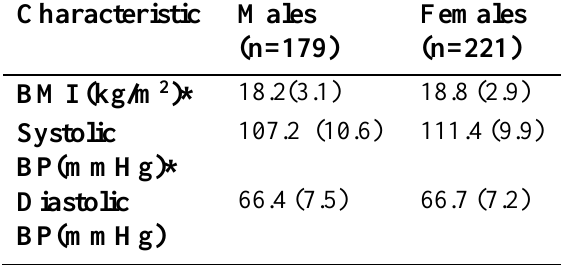
Table 1. Mean BMI, Systolic and Diastolic Blood Pressure according to sex